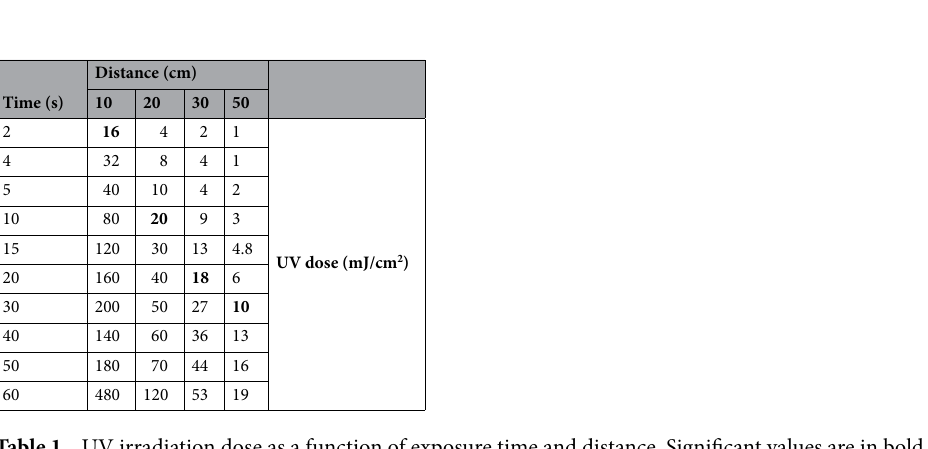
Figure 4. Verification of SARS-CoV-2 reduction as a function of ultraviolet C (UVC) exposure time and distance. After staining Vero E6 cells with crystal violet, 50% tissue culture infective dose (TCID 50 ) was calculated using the Spearman–Karber method. ( A ) Determination of viral titer at variable radiation exposure time and distance between the UV light-emitting diode (UV-LED) and plated virus. ( B ) Determination of viral reduction rate over time at varying UV irradiation distance (* p ≤ 0.05, ** p ≤ 0.005, *** p ≤ 0.0005 vs. 50 cm condition).